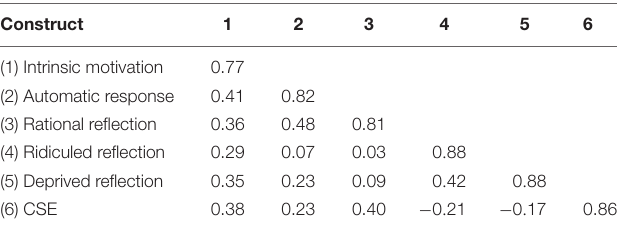
TABLE 3 | Discrimination validity